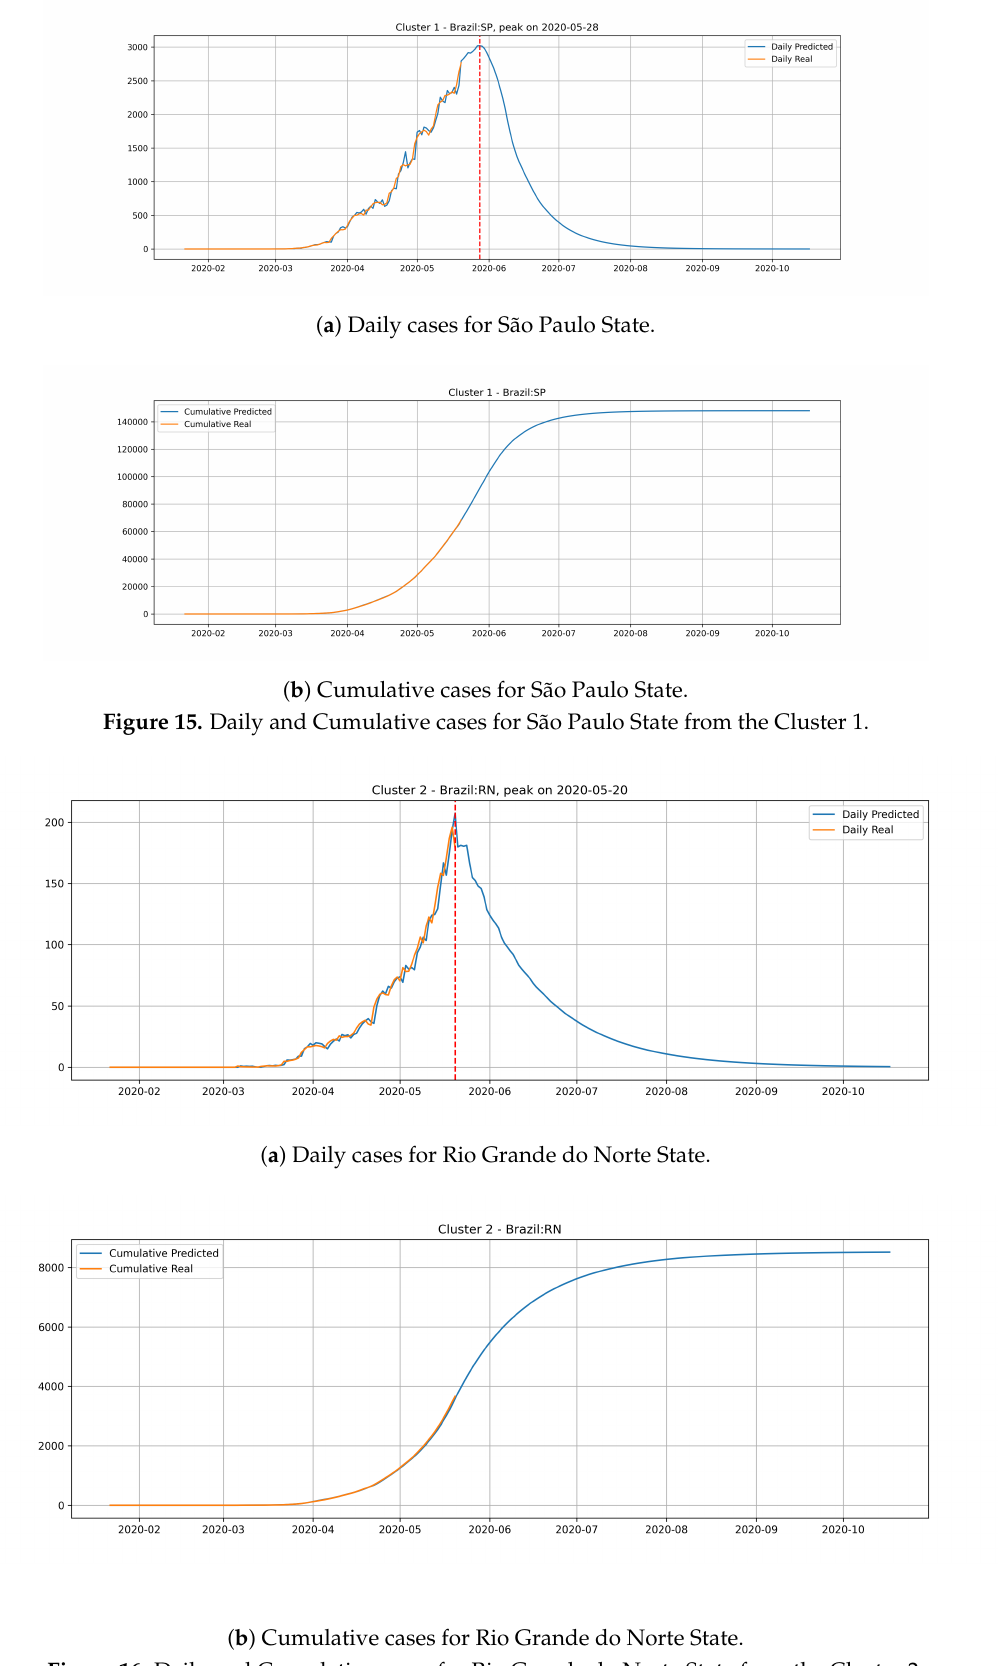
Figure 16. Daily and Cumulative cases for Rio Grande do Norte State from the Cluster